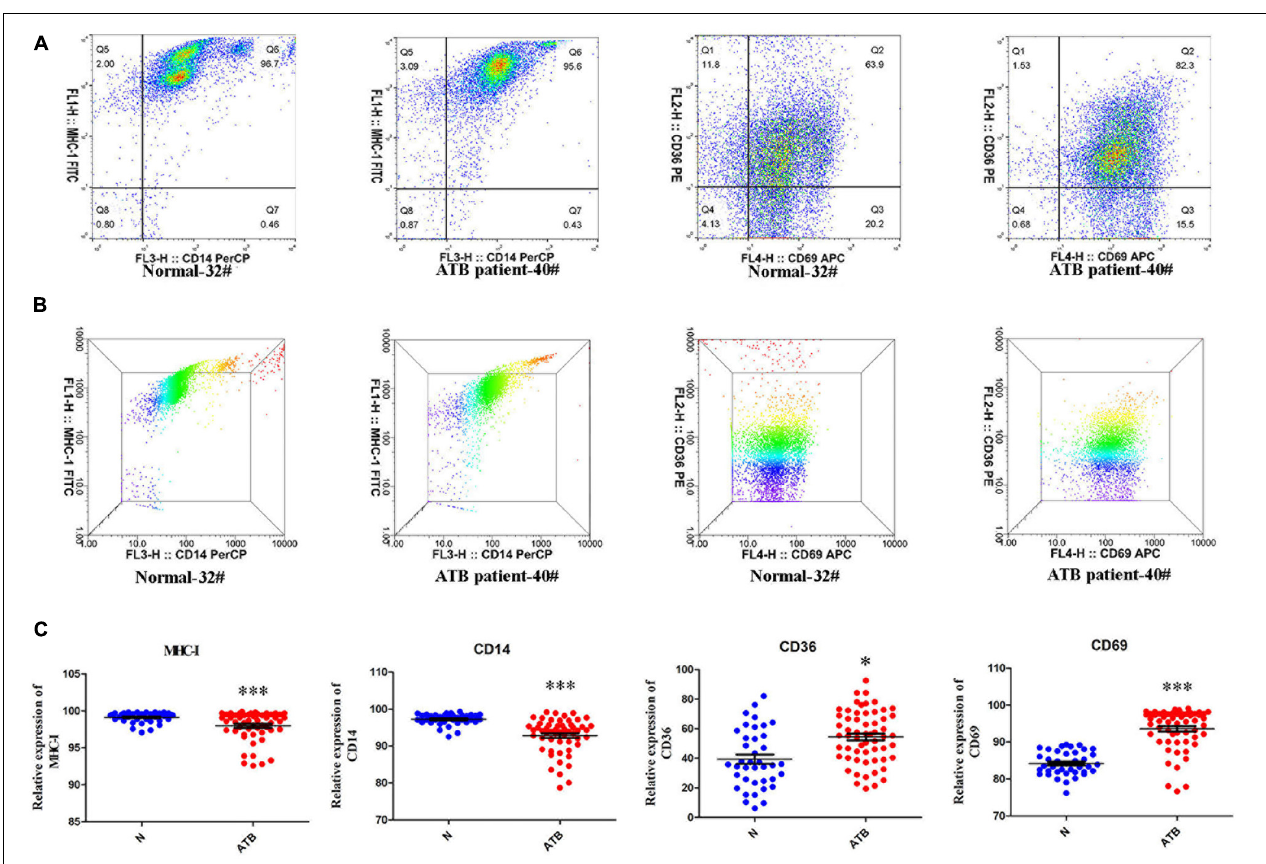
FIGURE 5 | MHC-I, CD36, CD69, and CD14 expression in the PBMCs of normal individuals and patients with ATB. (A,B) Scatter diagram and three dimensional results of MHC-I, CD36, CD69, and CD14 expressions in PBMCs of normal individual-32# and ATB patient-40# were detected by flow cytometry and analyzed using flowjo10 software. (C) Scatter statistical results for MHC-I, CD36, CD69, and CD14 in 40 normal individuals and 55 ATB patients were quantified using GraphPad Prism 5 software. * p < 0.05, *** p <